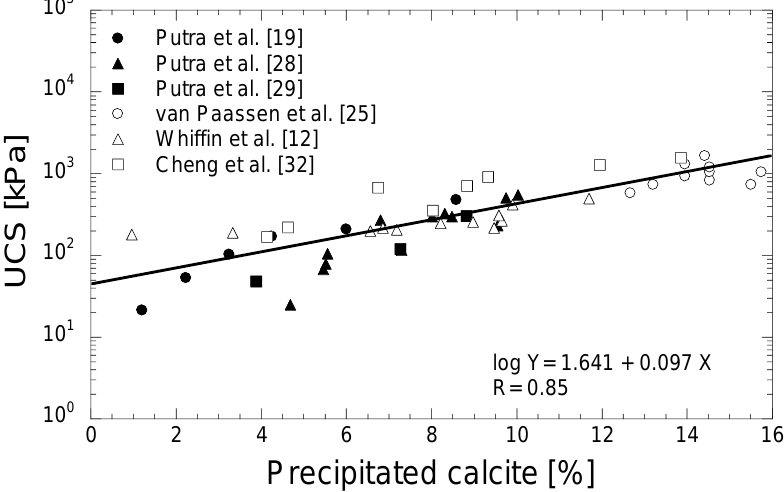
Figure 5. Strength of treated sand for several masses of precipitated calcite